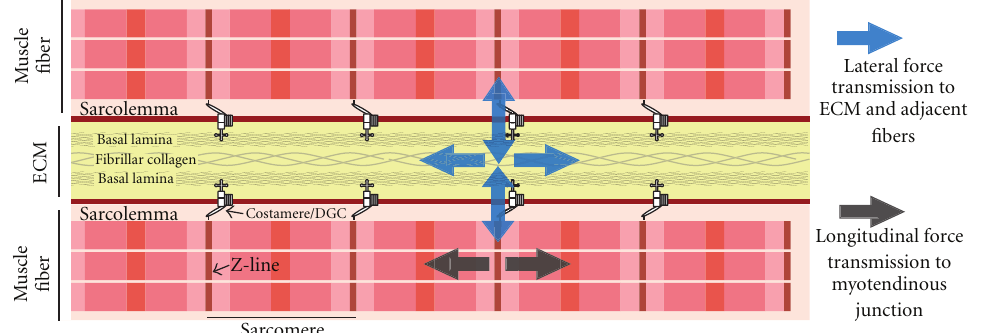
Figure 3: The dystrophin-glycoprotein complex transmits forces laterally at costameres in muscle. Longitudinal forces generated in sarcomeres are transmitted down myofibrils in muscle and forces are also transmitted laterally to the ECM and neighboring muscle fibers at costameres, at least in part through the dystrophin-glycoprotein complex (DGC). Recent data showing a loss of lateral force transmission in dystrophin-deficient muscle explains how the reduction or improper assembly of the DGC at the lateral membrane may contribute to overall muscle weakness and